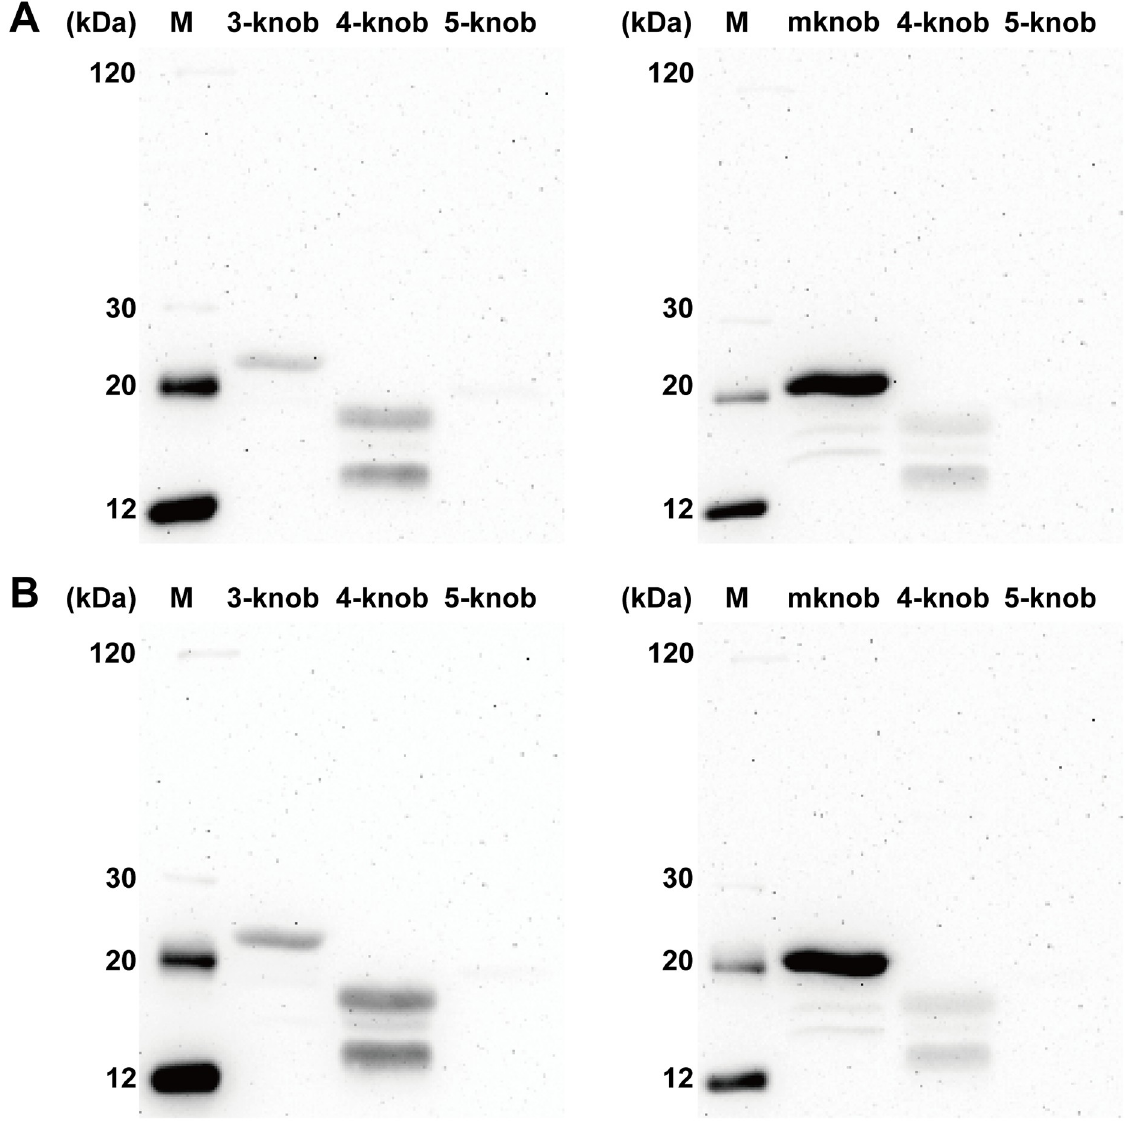
Fig 9. Western blot analysis of Fabs 2A6 and 4E2 binding to knob proteins under denaturing and reducing conditions. Note that Fabs 2A6 (A) and 4E2 (B) bind to the knob proteins of HAdV-B3 and E4 with molecular masses of about 23 kDa and 18 kDa, respectively, with preheating. However, both Fabs did not recognize the HAdV-C5 knob protein with preheating. In addition, a band around 20 kDa, which is the predicted molecular weight of the mutant knob (mknob) protein with preheating, was detected with both Fabs. Two non-specific bands appeared below the knob proteins of HAdV-B3 and E4, but these were not found with SDS-PAGE, suggesting that the concentrations were low. These non-specific proteins could be purified by Ni-NTA resin and recognized by Fab, suggesting that they contained the 6 × His tag and the linear epitope. We inferred that these non-specific proteins were produced as partially expressed knob proteins that were degraded in E . coli